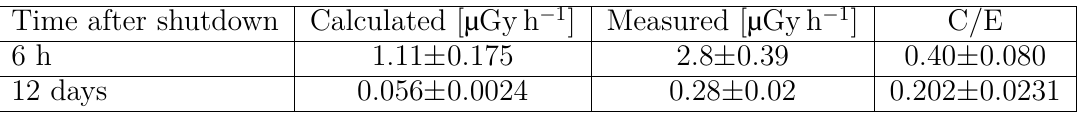
Table 2: Comparison of measured and calculated dose rates µ Gy h − 1 in the Ionization chamber of JET octant 2. Dose rates calculated by other code packages and measured dose rates obtained from [10]. 1 σ uncertainties are